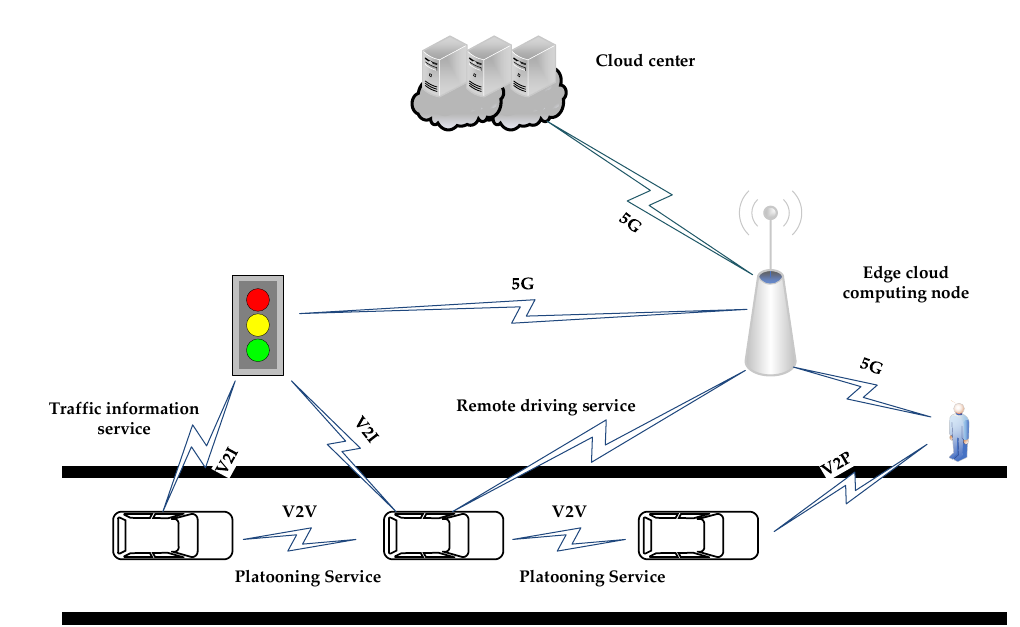
Figure 1. V2X applications deployed in edge computing.